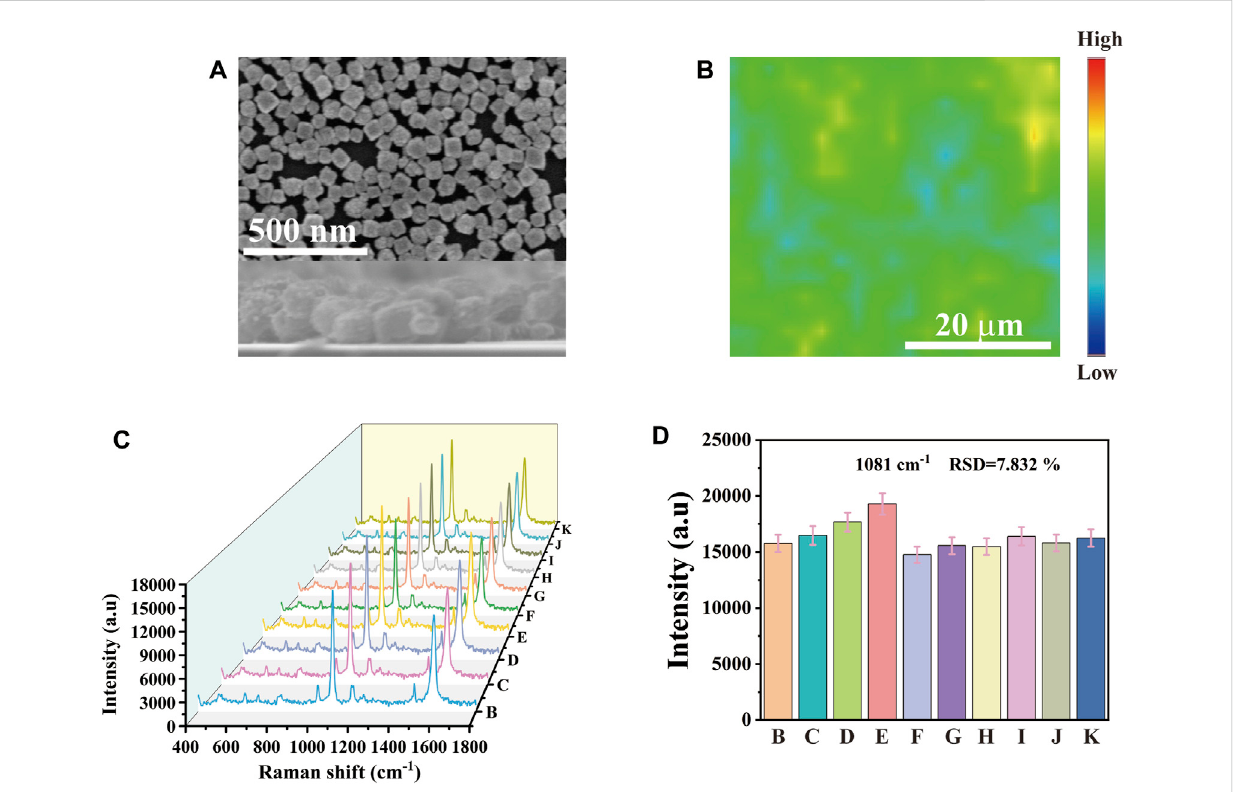
FIGURE 2 (A) SEM of cross section and plane for monolayer Au-AgNBs array. (B) SERS mapping of Au-AgNBs array at 1,081 cm − 1 . (C) SERS spectra with a peak intensityof1,081 cm − 1 wereobtainedfrom10randomlyselectedpointswithinthe40×40 μ m 2 regionofthesubstrateoftheAu-AgNBsarrayand (D) the histogram of spectral intensity at 1,081 cm − 1